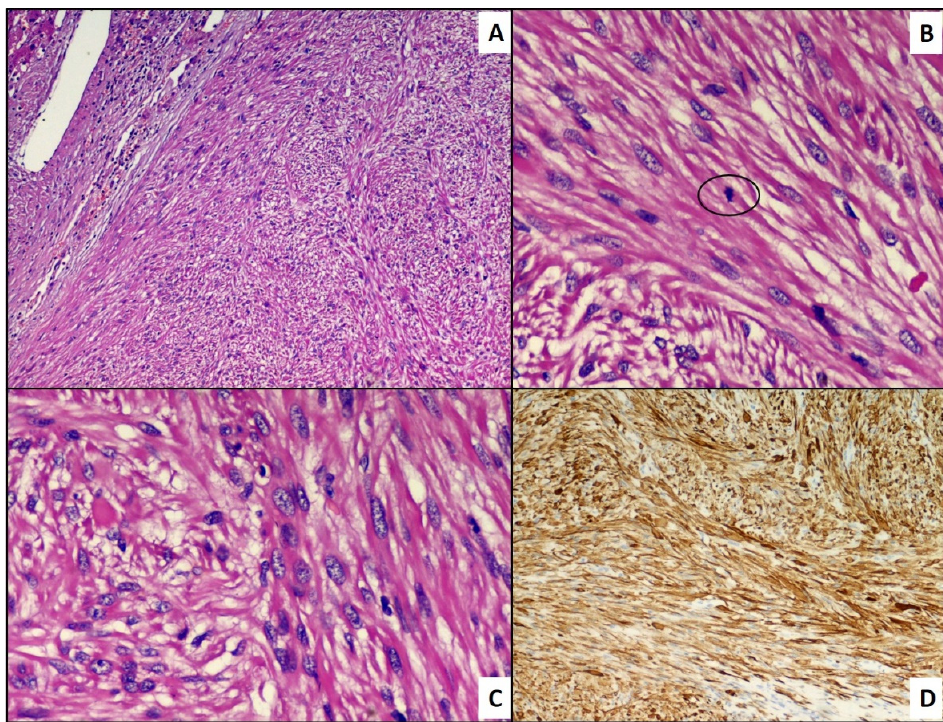
Figure 3. ( A ) Histological preparation including a proliferation of mesenchymal cells more atypical than the previous finding. Note the jagged and less clear and defined edges of the lesion (hematoxylin–eosin, original magnification: 10×). ( B ) Histological detail of a circled atypical mitotic figure (hematoxylin–eosin, original magnification: 40×). ( C ) Histological detail of the lesion: note the greater cellular crowding and nuclear irregularities (hematoxylin–eosin, original magnification: 40×). ( D ) Positive immunostaining for smooth muscle actin (immunohistochemistry, original magnification: 10×).